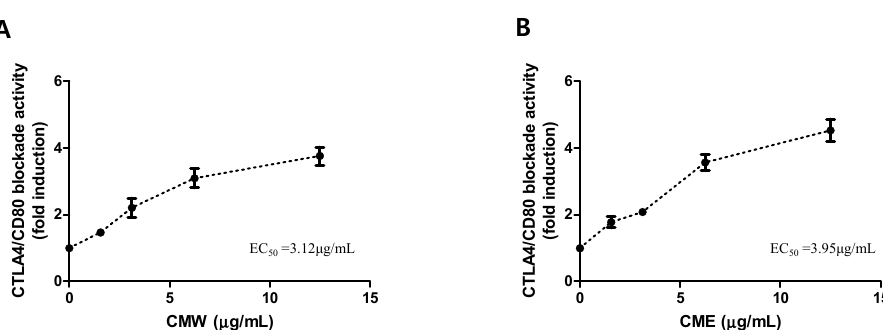
Figure 2. Nuclear factor of the activated T cell (NFAT) luciferase reporter activity by CTLA-4/NFAT Reporter-Jurkat T cells treated with Chaga mushroom/water extract (CMW) and Chaga mushroom/70% EtOH extract (CME). Fold luminescence of Jurkat T cells treated with CMW ( A ) and CME ( B ) at several concentrations (1.56 to 12.5 μ g/mL). The half-maximal effective concentration (EC 50 ) was calculated using the Prism “log[agonist] vs. normalized response” equation. All results are presented as the mean of three independent biological replicates and compared with the vehicle control group.